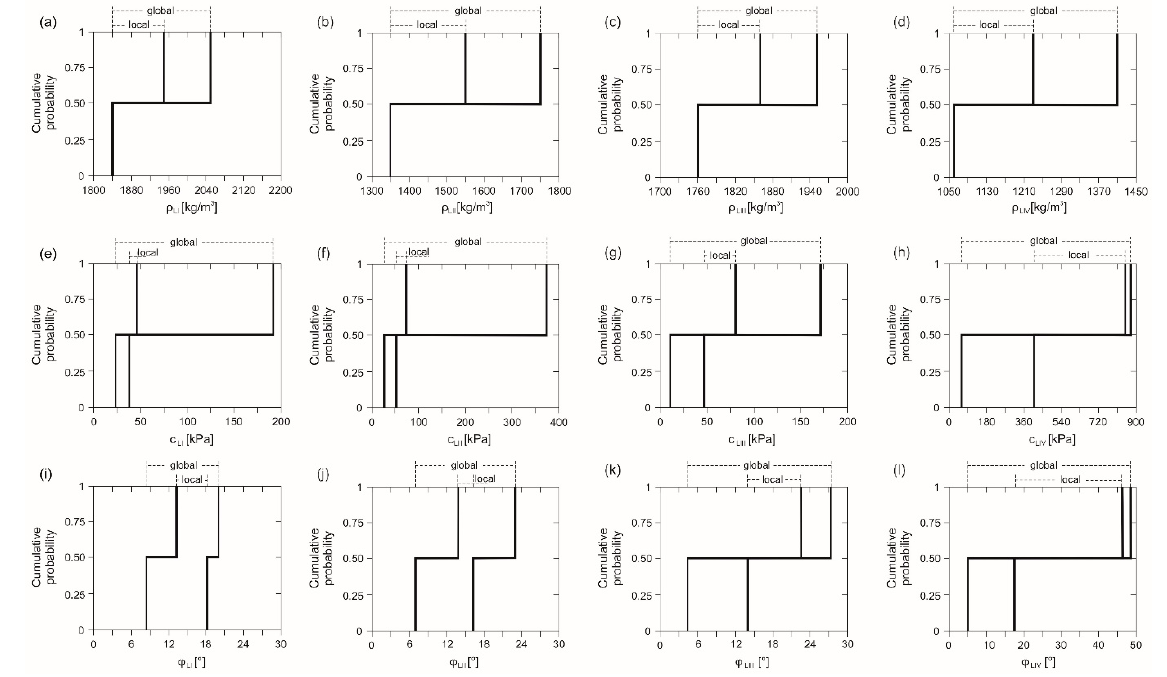
Figure 9. Input data–bulk density, cohesion, and internal friction angle presented as random sets for lithological units: ( a , e , i ) LI; ( b , f , j ) LII; ( c , g , k ) LIII; ( d , h , l ) LIV.